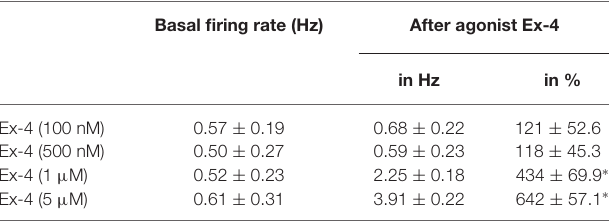
TABLE 1 | Changes in firing rate in gonadotropin-releasing hormone (GnRH) neurons upon Exendin-4 administration at various concentrations of this agonist. Basal firing rate (Hz)